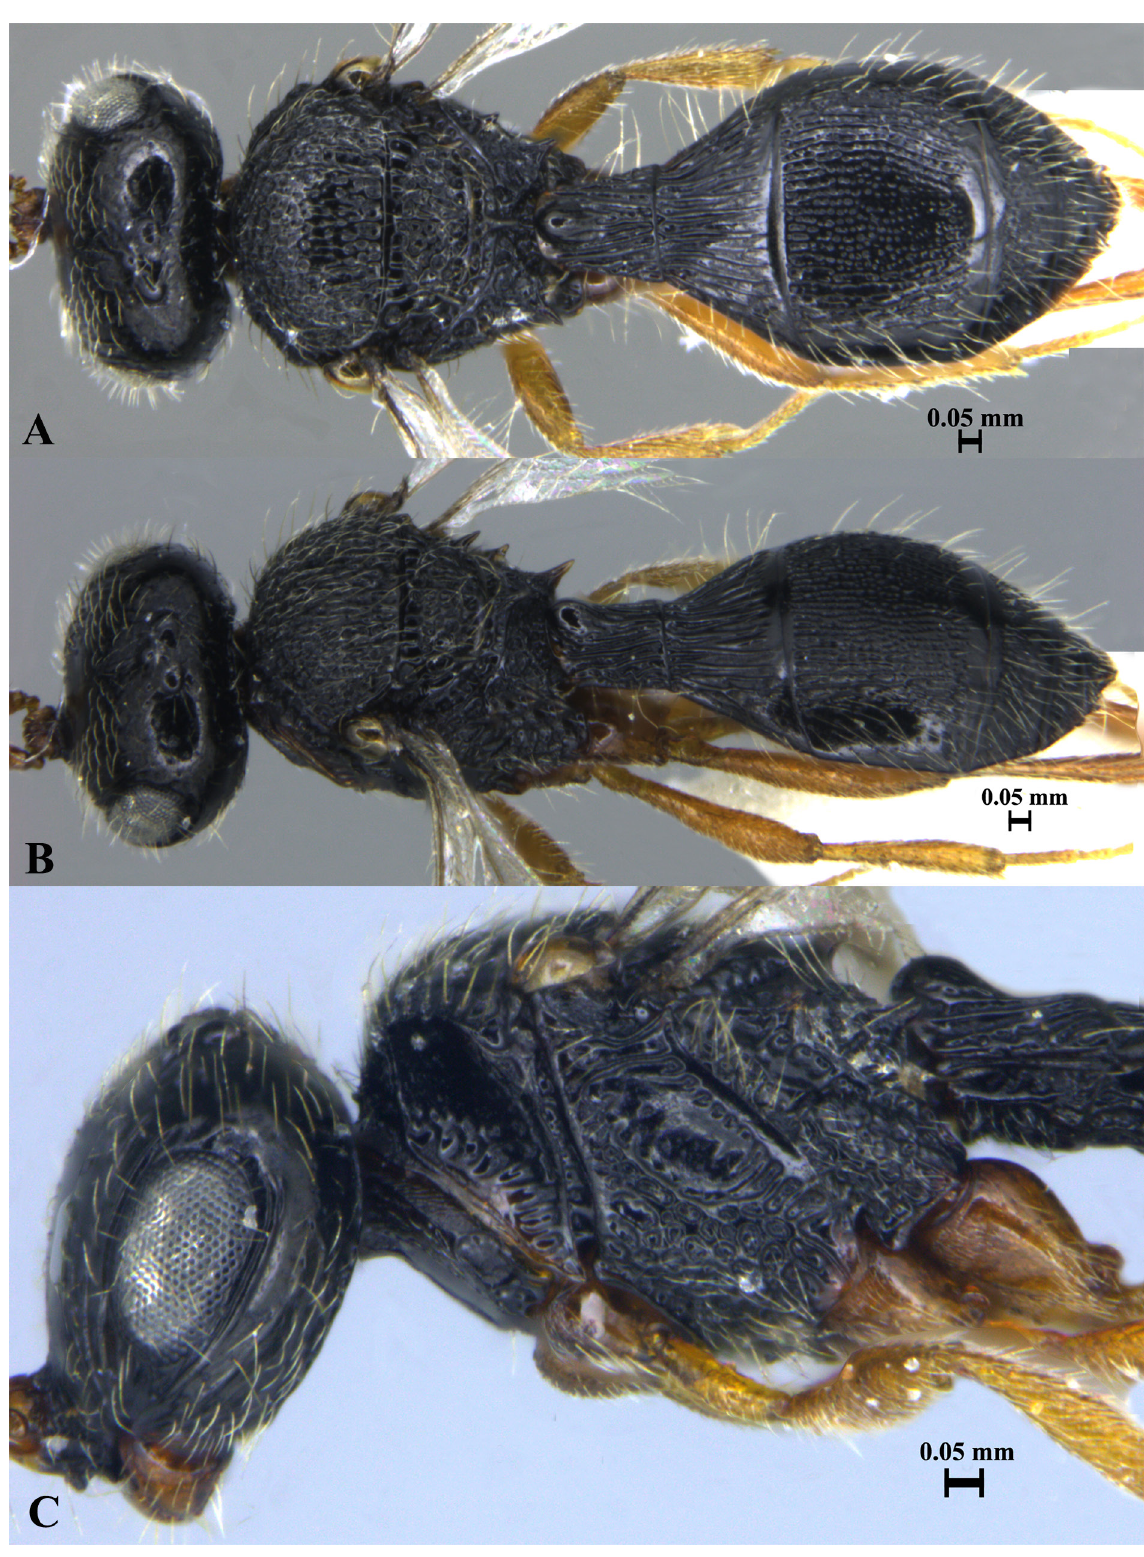
Fig. 1. Odontoscelio agnieleae sp. nov. Holotype, ♀ (ICAR-NBAIR P3963). A . Habitus (dorsal view). B . Habitus, showing axillular spines. C . Head and